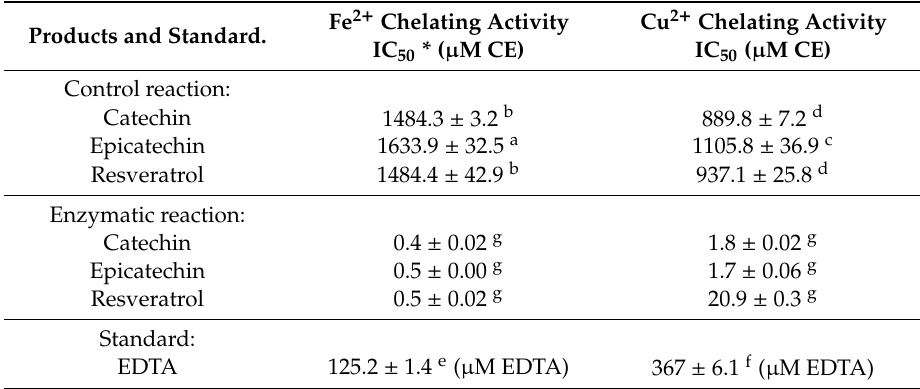
Table 1. IC 50 values of monomers and oligomers of catechin, epicatechin, and resveratrol, obtained from the control and enzymatic reactions after 2 h of reaction. Products and